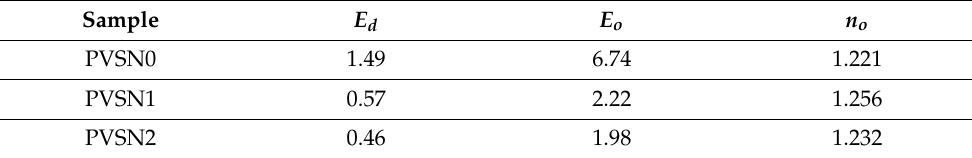
Table 2. E o and E d for the PVA and loaded films.